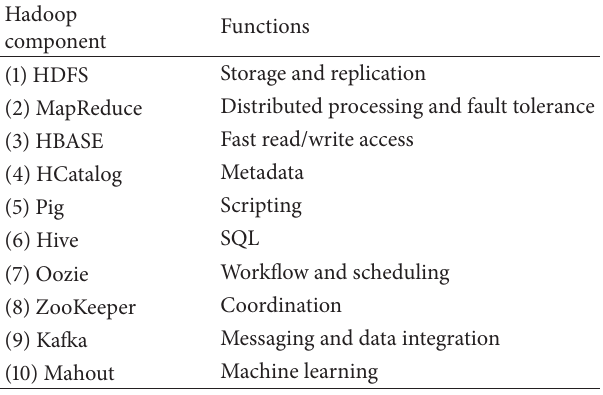
Table 2: Hadoop components and their